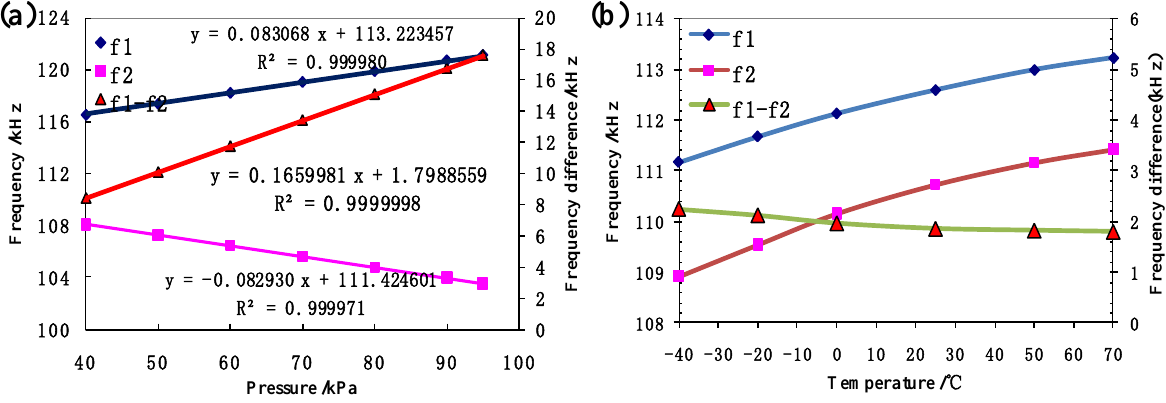
Figure 8. ( a ) The intrinsic resonant frequencies of these two resonators as a function of pressure, producing a sensitivity of about 166 Hz/kPa and a linearity with a coefficient of 0.9999998 based on the differential setup; ( b ) Two resonators demonstrated similar temperature drifts and the temperature caused frequency drift was reduced by the differential